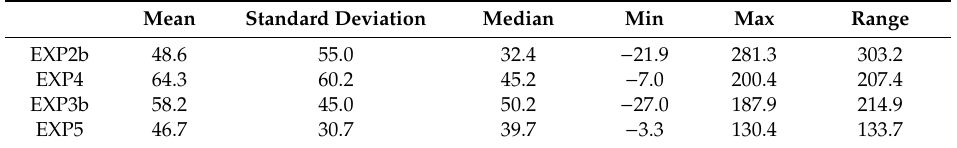
Table 19. LHF (W m − 2 ) simulated by UTOPIA and NOAH, initialized with GLDAS, at the CO station.